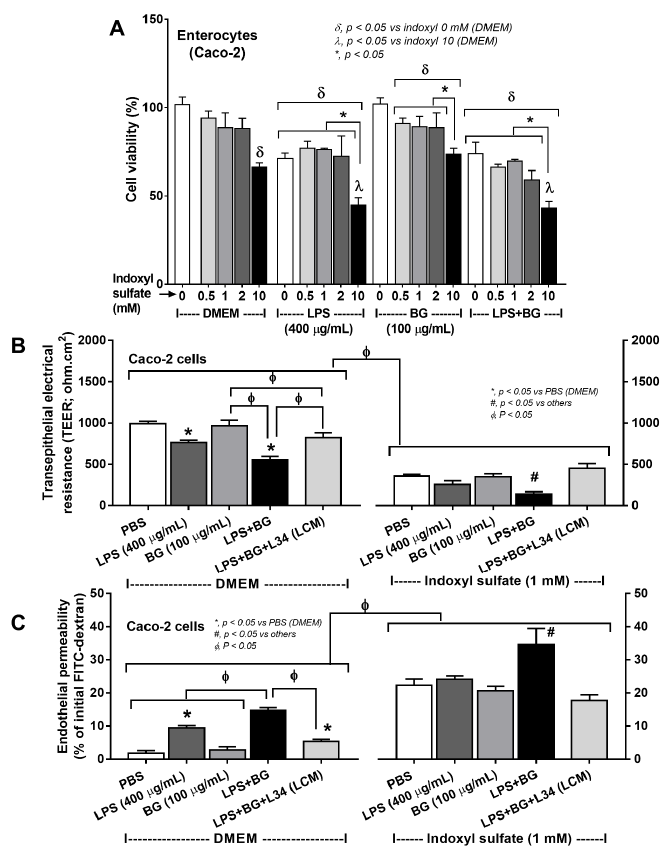
Figure 5. ( A ) The cell viability (MTT assay) of enterocytes (Caco-2 cells) after incubation by the different concentrations of indoxyl sulfate together with culture media control (using DMEM; Control) or lipopolysaccharide (LPS) at 400 μ g/mL with or without (1 3)- β -D-glucan (BG) at 100 μ g/mL are demonstrated. ( B ) The transepithelial electrical resistance (TEER) and ( C ) enterocyte permeability (FITC-dextran 4.4 kDa) in stimulated Caco-2 cells with or without 1 mM indoxyl sulfate, a representative uremic toxin, are also demonstrated (independent triplicate experiments were performed for the in vitro experiments).